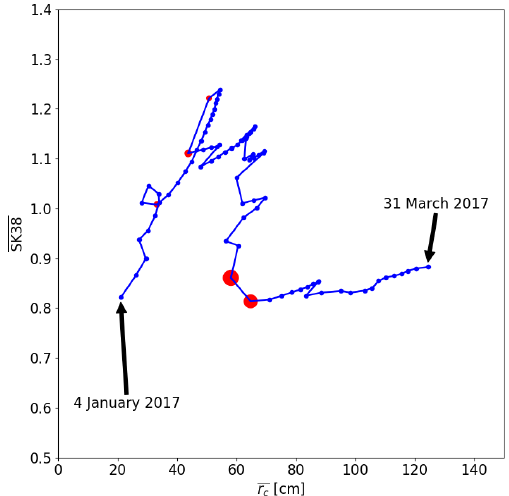
Figure 8. SK38 with r c of the reference run for all days from 4 Jan- uary 2017 to 31 March 2017. Red circles are days with AAI > 10, and the size of the circles corresponds to the value of